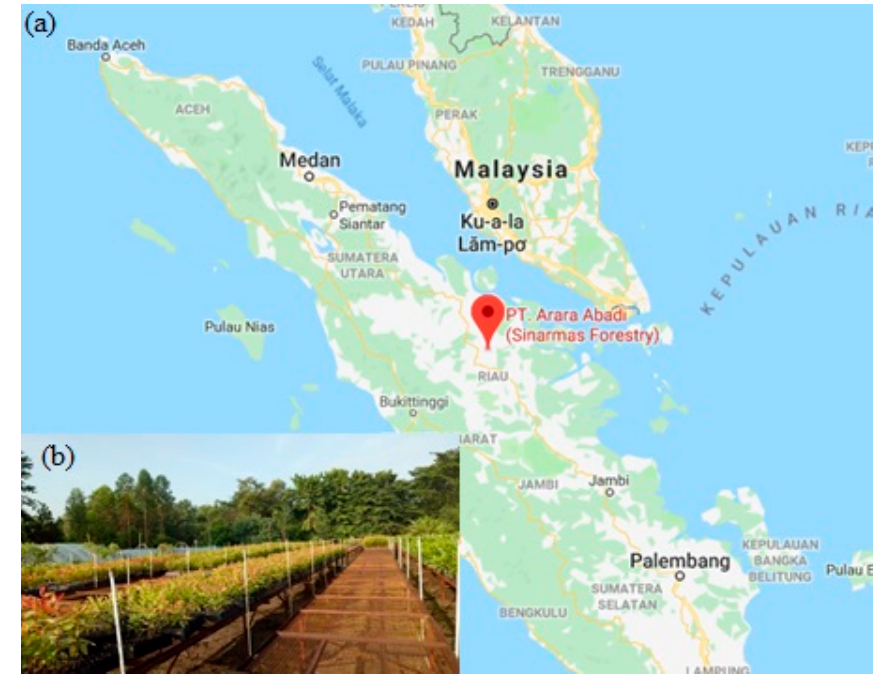
Figure 1. Location of the study site in Riau Province, Indonesia ( a ), and Eucalyptus pellita plants growing in open nursery beds ( b